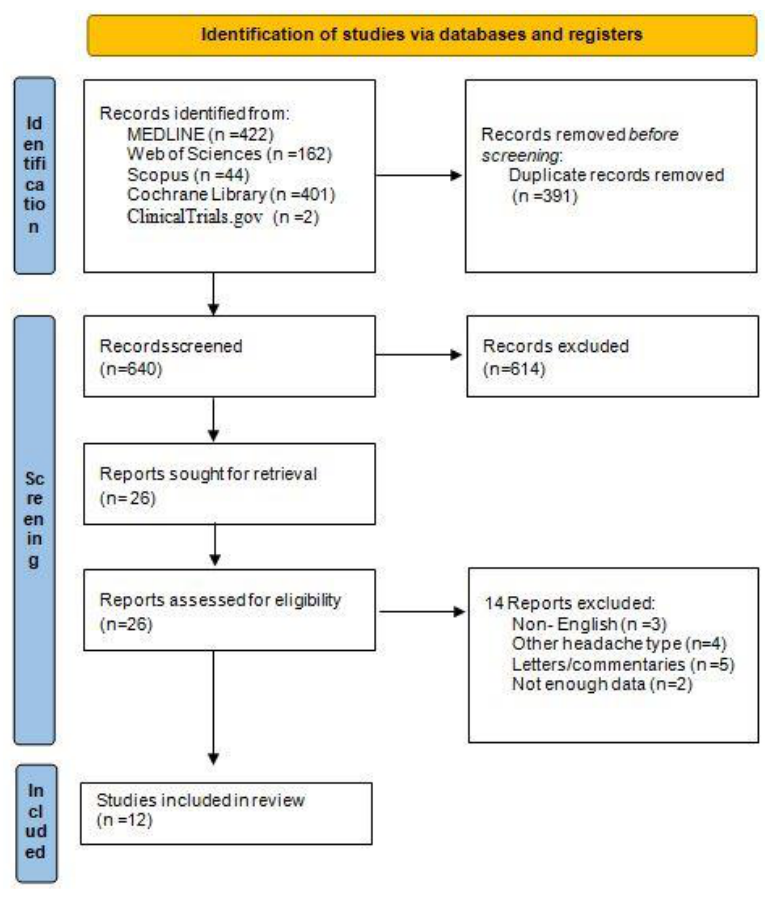
Figure 1. PRISMA 2020 flowchart.